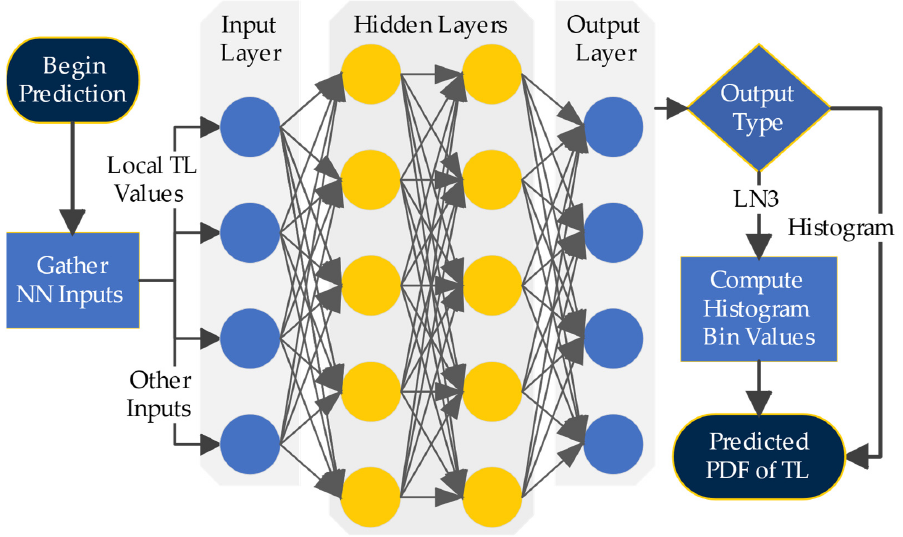
Figure 5. Algorithm block diagram for a NN prediction of a PDF of TL. When presented with a new